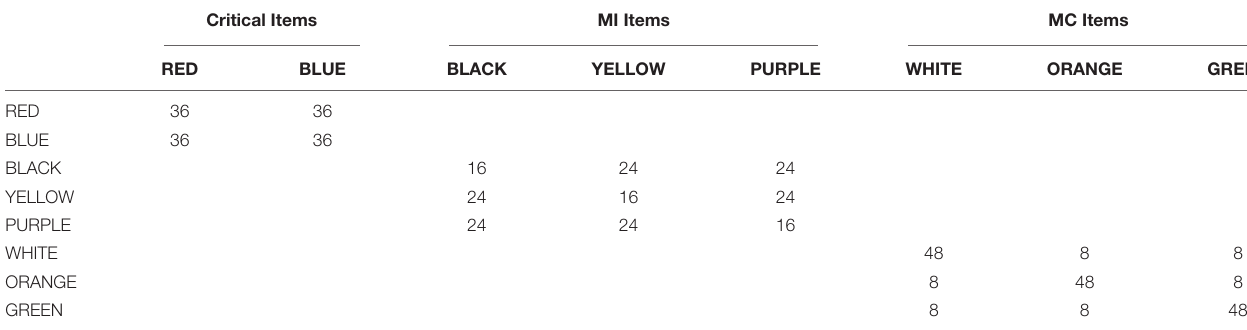
TABLE 4 | Stimuli frequencies in Experiment